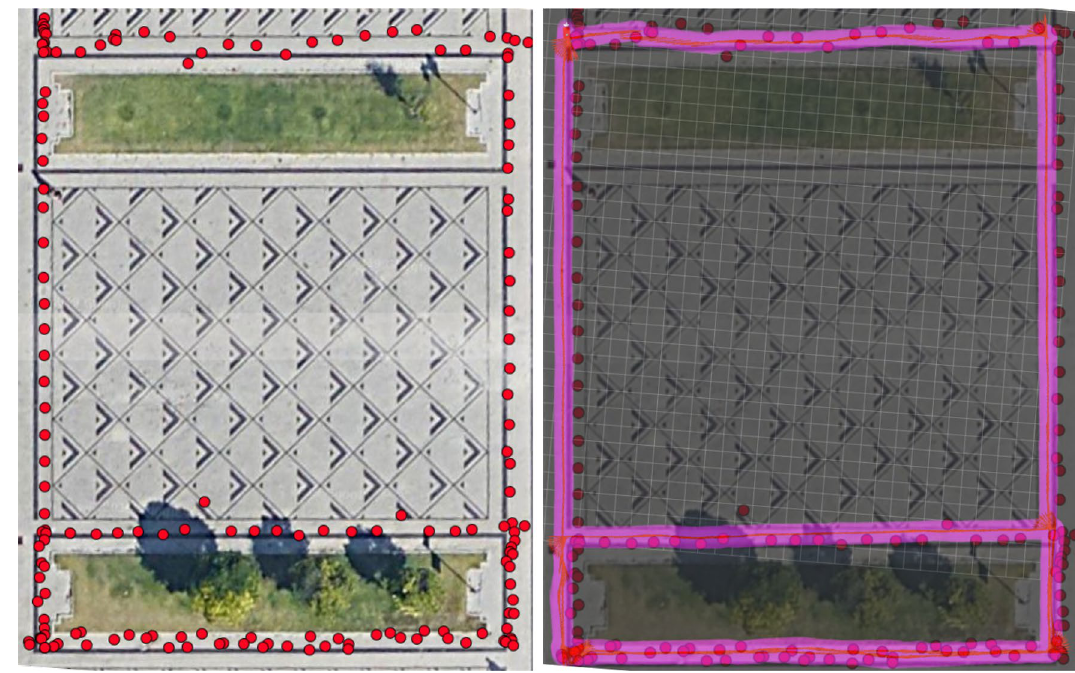
Fig. 6 Results from an outdoor localization experiment. Left: Google Maps view with raw GPS coordinates. Right: EKF-based localization estimates using the Odometry + IMU + GPS information (red line) along with the covariance of the estimates (pink)